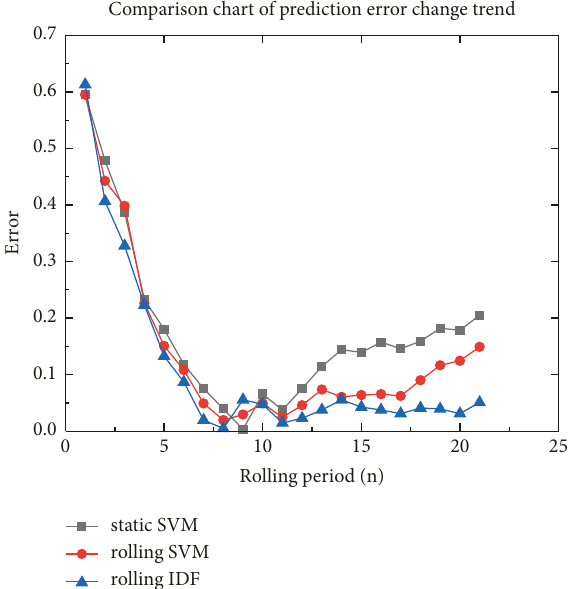
Figure 12: Comparison of prediction errors of three methods. Table 11: Comparison of period-based prediction